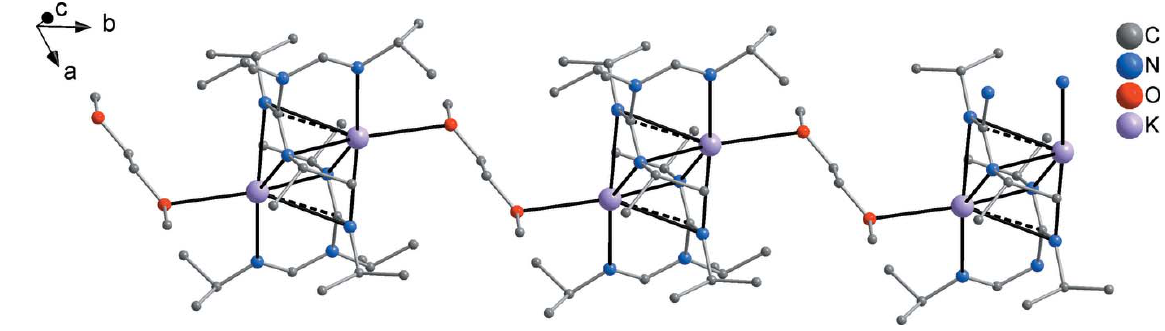
Figure 3 Illustration of the polymeric chain structure of the title compound, extending along the crystallographic b axis.